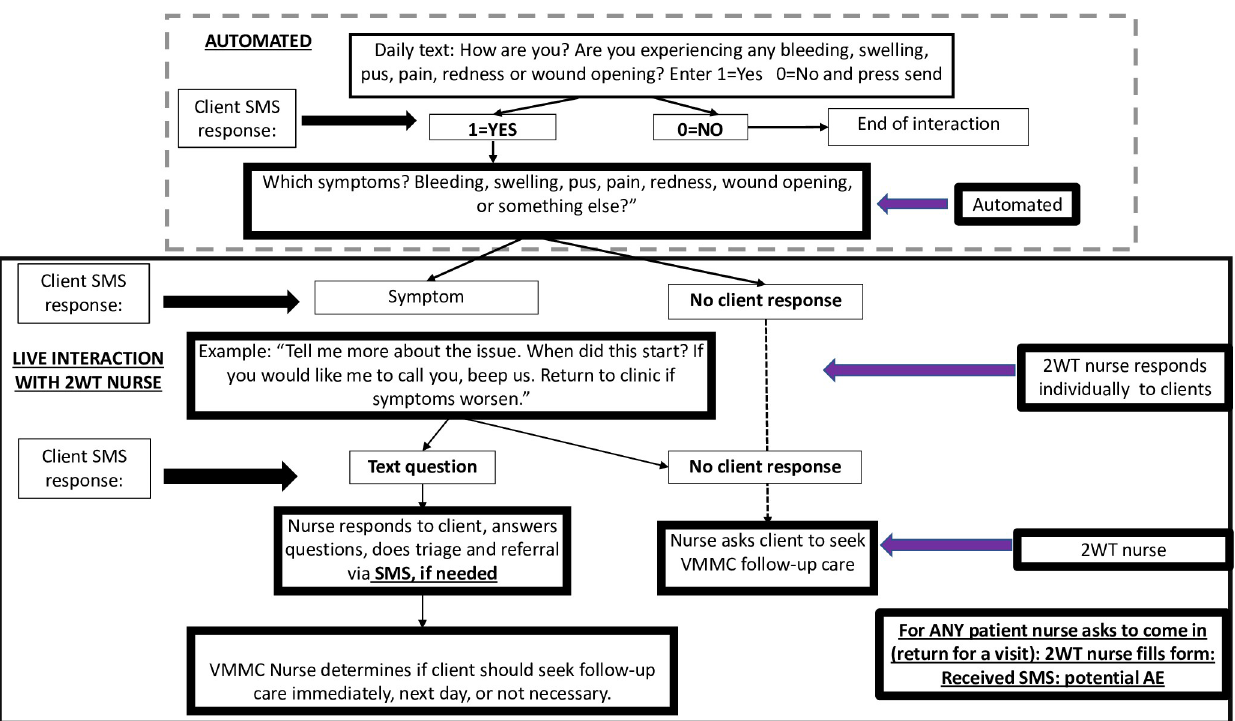
Fig 4. 2wT RCT flow chart. Fig 4 flow displays hybrid 2wT, with both automated and interactive (manual) SMS, interaction between patients and providers in a centralized model where a single site’s clinical provider(s) manages 2wT patients enrolled at that specific